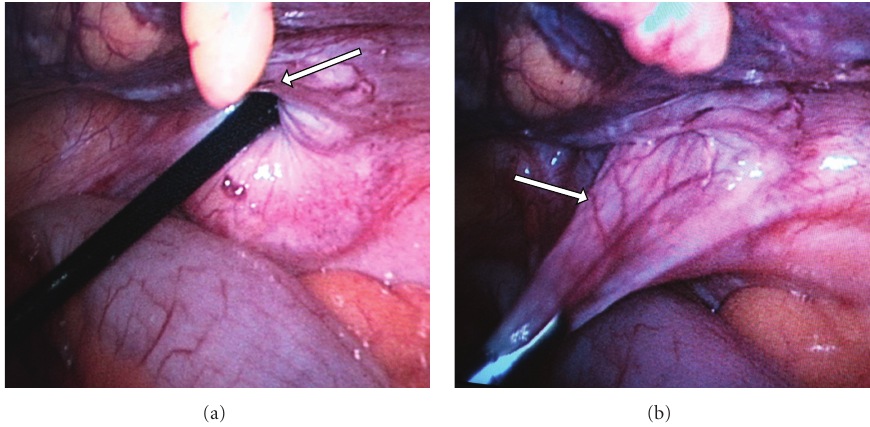
Figure 2: (a) The laparoscopic grasper tool demonstrating the slit like “Spigelian defect”. (b) The hernia sac (arrow) after laparoscopic reduction of the incarcerated